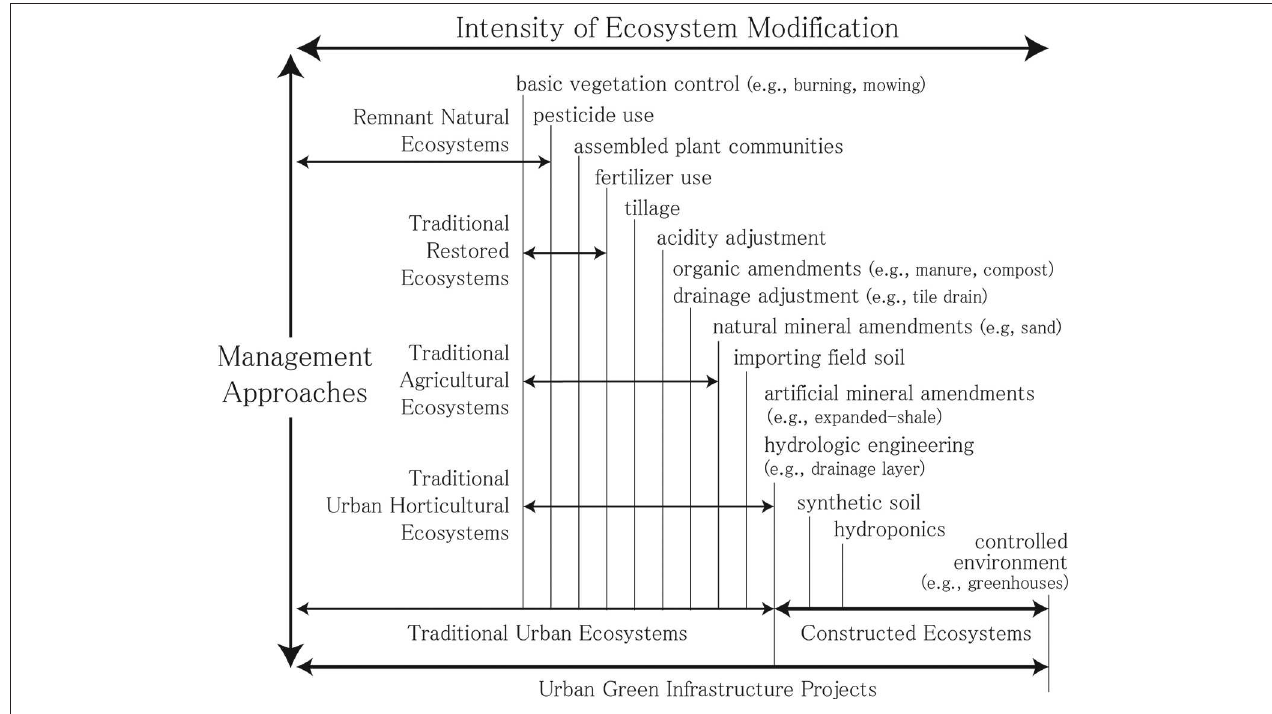
FIGURE 2 | Types of Urban Ecosystems and Intensity of Ecosystem Modification. (adapted from Figure 2 in Sloan et al., 2012).